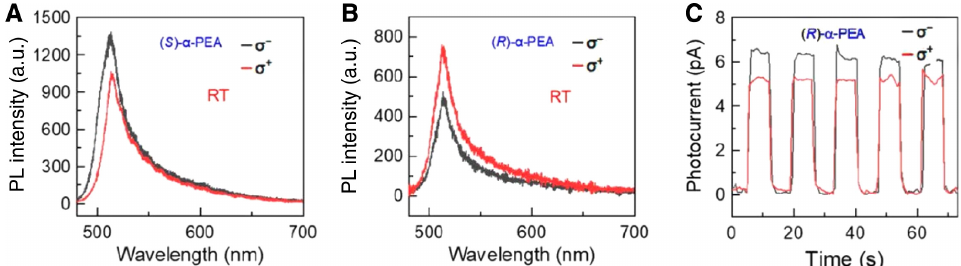
PbI perovskites. 2 4 PbI and ( R )- α -(PEA) PbI crystals. (C) Optical switching characteristic of the ( R )- α - 2 4 2 4